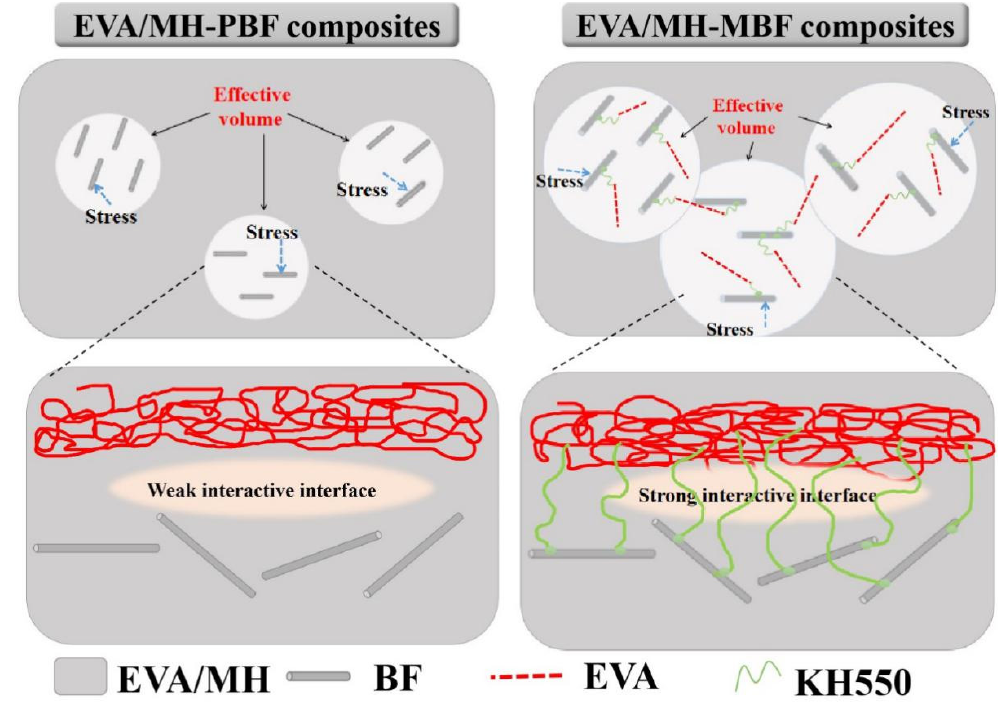
Figure 10. Schematic diagram of the force acting on composites.